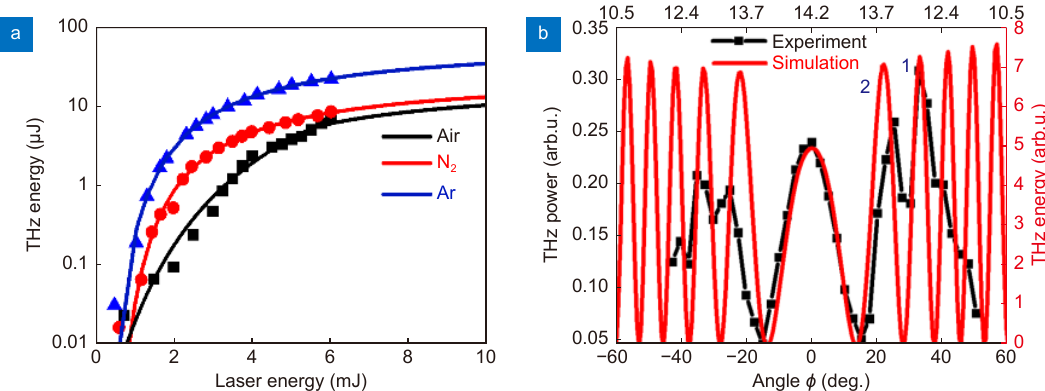
Fig. 3 | Variation of the output THz pulse energy as a function of ( a ) pumping laser energy in different gases and ( b ) tilting angle of α-BBO (bot- tom axis), i.e. the time delay between the fundamental and second harmonic laser beams (upper axis) in argon. In (a): black squares – ambient air, red circles – nitrogen, and blue triangles – argon; solid lines: data fitting curves. (b) black squares: experimental data; red line: numerical sim- ulation